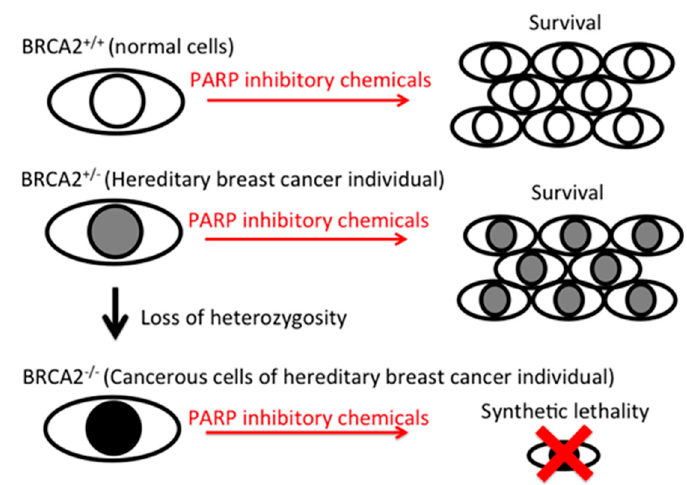
Figure 5. Diagram of PARP inhibitory effect-induced synthetic lethality to BRCA2-deficient cells. BRCA2 normal cells and BRCA2 heterozygous mutated cells can grow in the presence of PARP inhibitory chemicals, but BRCA2 homozygous mutated cells die due to synthetic lethality.